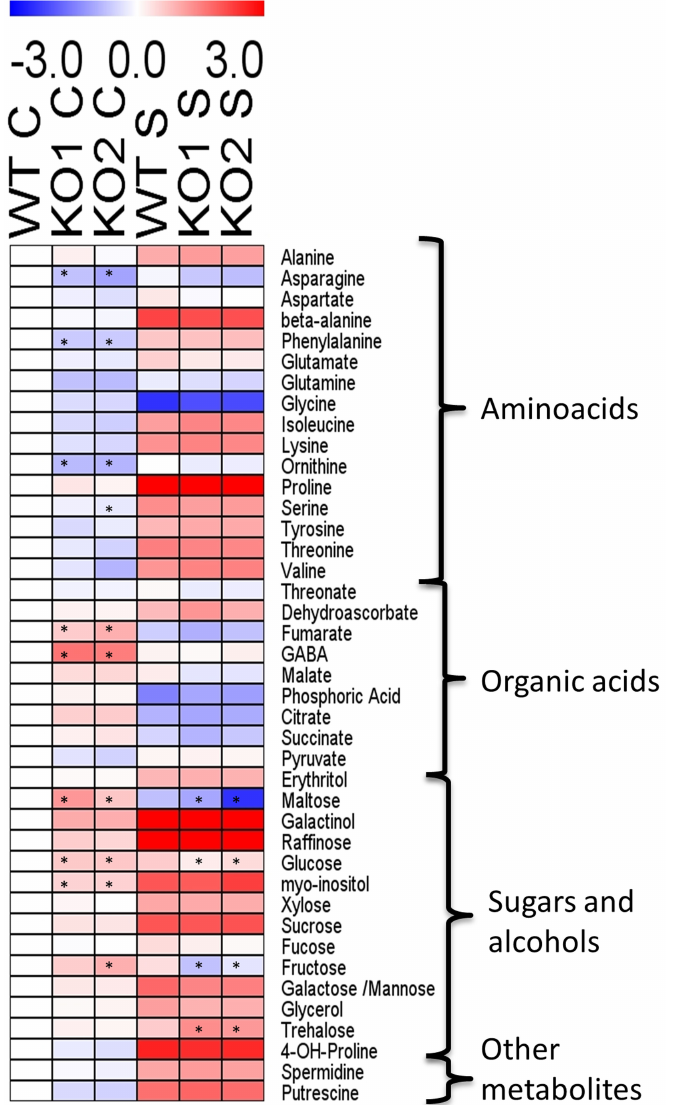
Figure 8. Heat map of relative levels of metabolites in leaves of A. thaliana wild type (WT) and two KO Attrxo1 mutant lines grown in the absence (Control) and presence of 100 mM of NaCl. Relative metabolite levels in leaves of all lines under control and saline conditions normalized with respect to the mean value of WT plants under control condition. Fold-changes were log 2 transformed (i.e., all metabolite levels from WT in control condition were 0). The red and blue colors represent the increases and decreases, respectively. The values represent the average from six samples and the asterisks indicate significant differences ( p < 0.05) from the WT in each condition using the t -Student’s test. The statistically significant differences between control and salinity of each genotype are presented in Table